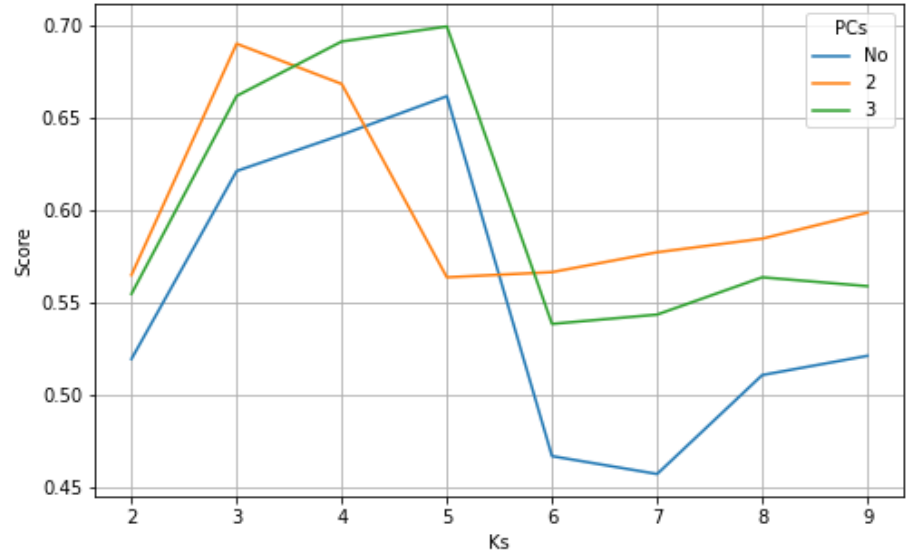
Figure 4. Silhouette scores calculated across the Cartesian